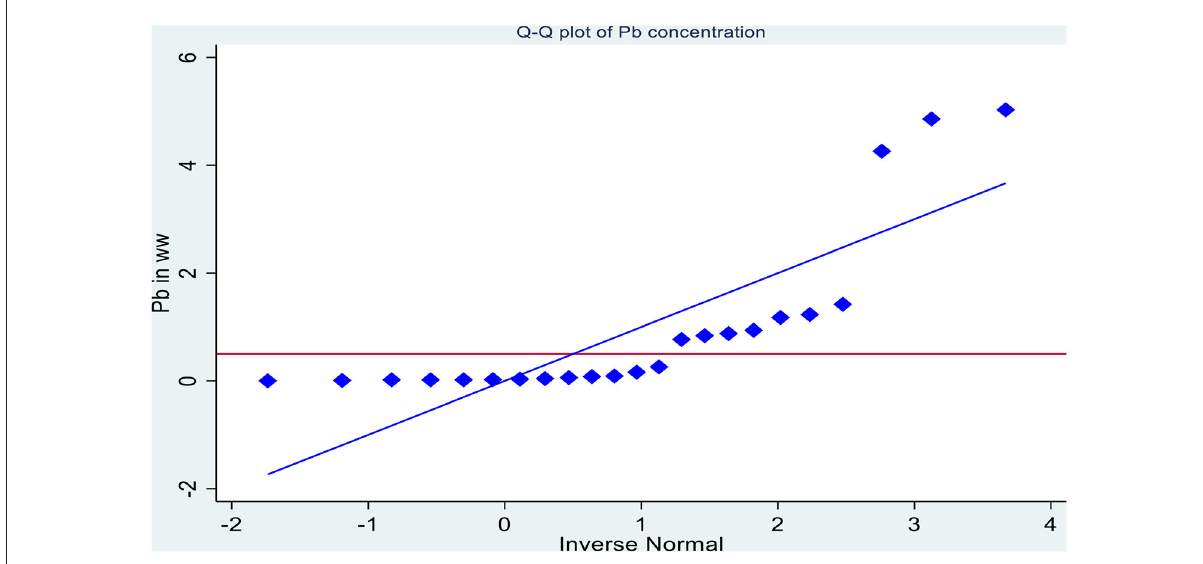
FIGURE4 The data distribution of Pb concentration in irrigation wastewater compared with the WHO/FAO limits of Pb level in irrigation water